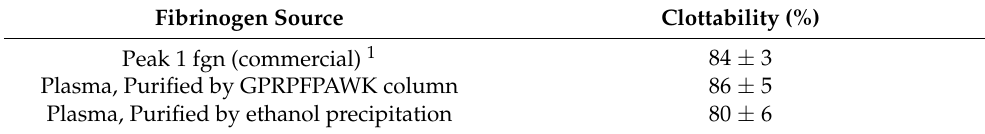
Table 1. Clottability values of fibrinogen purified by the GPRPFPAWK affinity